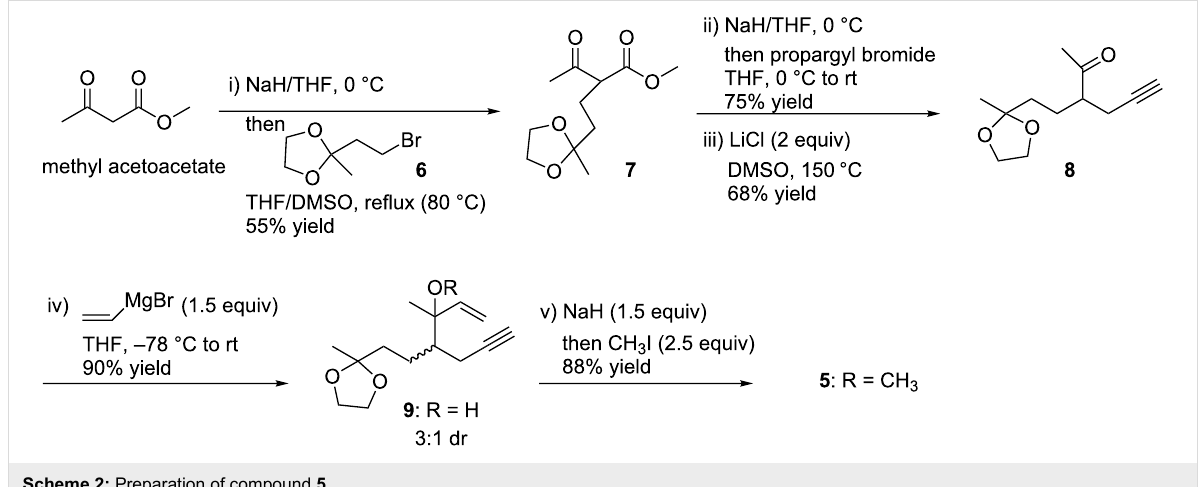
Scheme 2: Preparation of compound 5 .